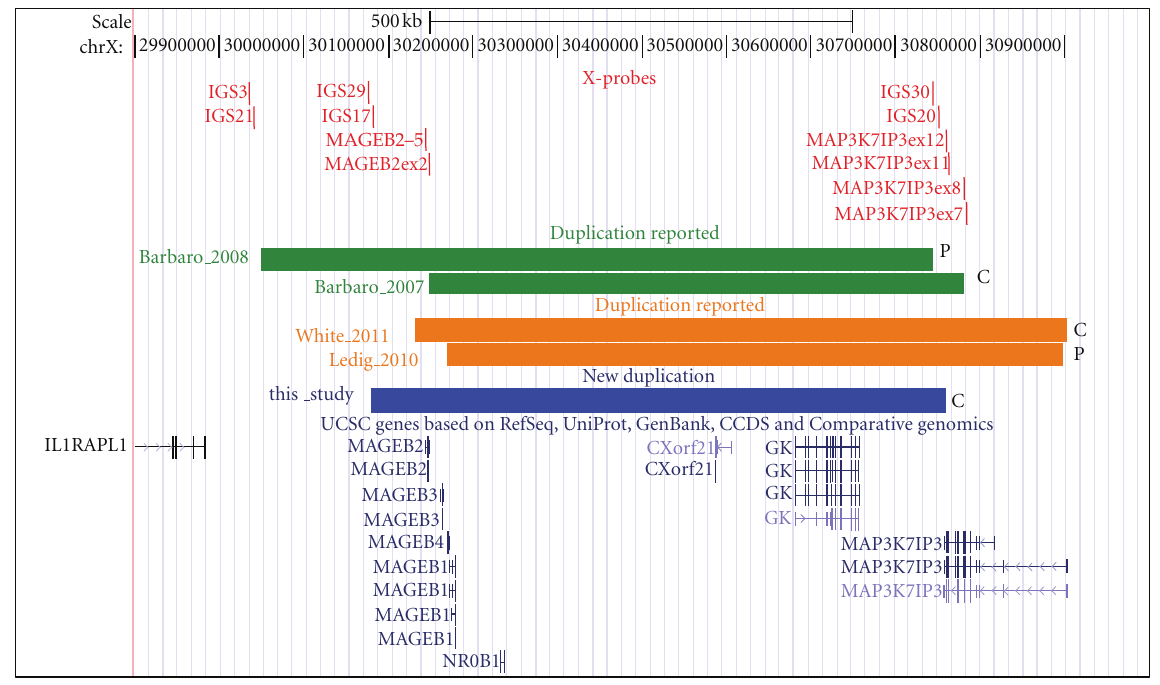
Figure 2: Comparison of NR0B1 locus duplications. Representation from the UCSC genome browser (NCBI36/hg18) of the NR0B1 locus on Xp21.2. The probes that delineate the breakpoints in the three independent families identified by our group are represented by red vertical lines. The horizontal blue line represents the extension of the duplication in the family here described, the green lines represent the duplicated regions previously described by our group, and the orange lines represent the two duplications identified by array CGH in patients with isolate 46,XY GD by other groups. The C and P at the right ends of the lines indicate if the GD was complete or partial,